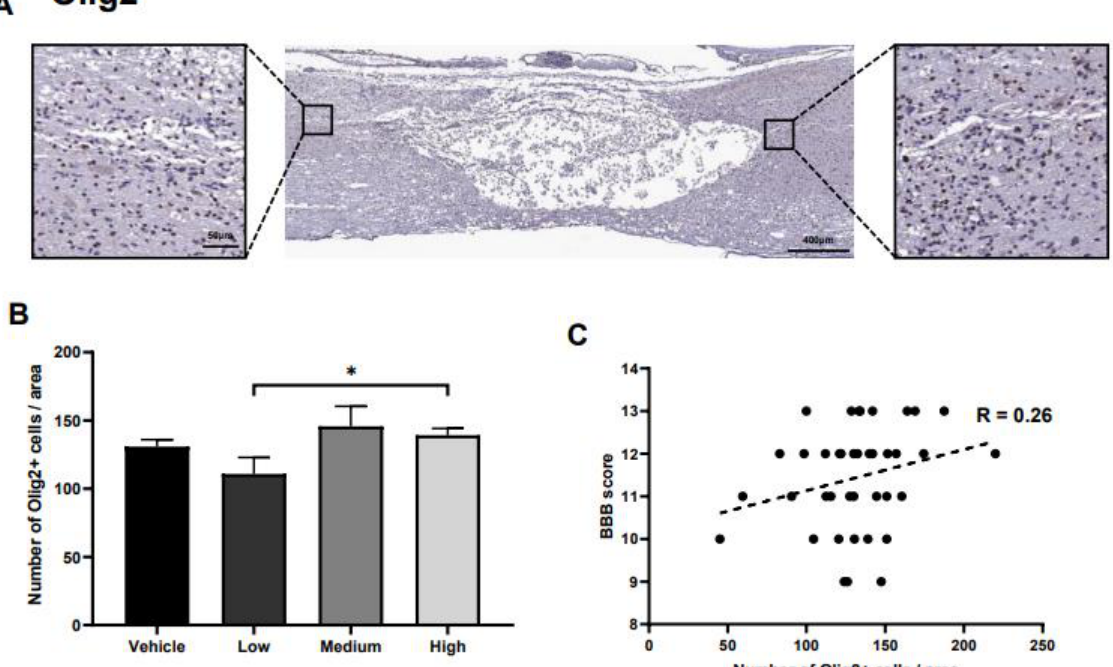
Figure 5. Effects of ahMNCs transplantation on oligodendrocytes. ( A ) Immunohistochemistry against Olig2. Scale bar = 400 and 50 µ m in the lower and higher magnifications, respectively. ( B ) The number of Olig2-positive oligodendrocytes was quantified and compared. Scale bar = 400 and 50 µ m in the lower and higher magnifications, respectively. ( C ) Correlation analysis between the number of Olig2 positive oligodendrocytes and the BBB score revealed the relationship between these two parameters. Height = Average, Error bar = Standard Error. *, P < 0.05.